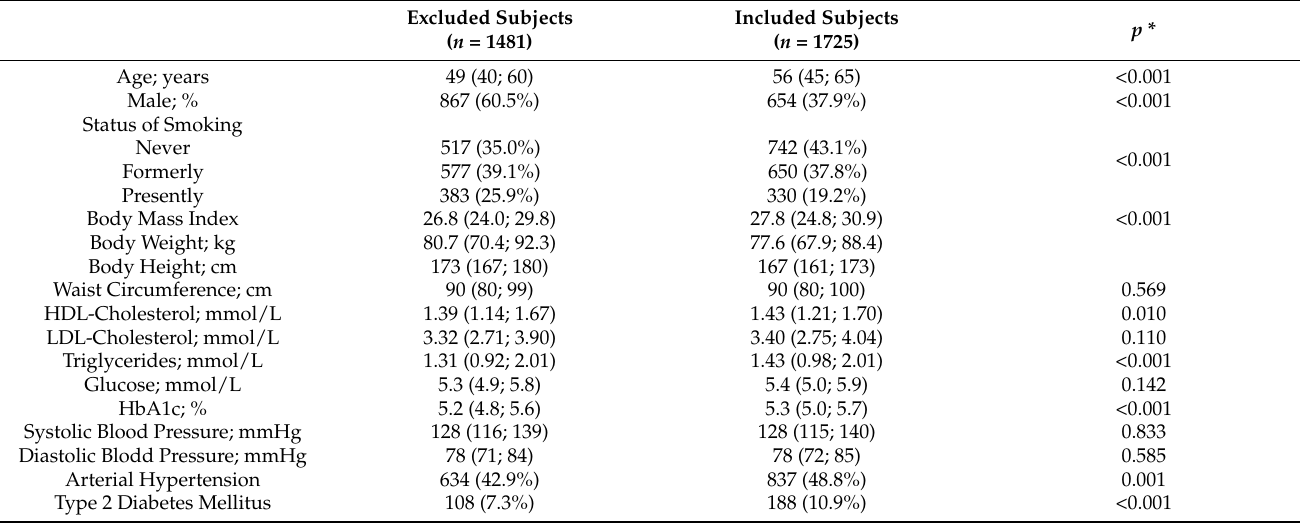
Table 1. Analysis of excluded and included subjects.